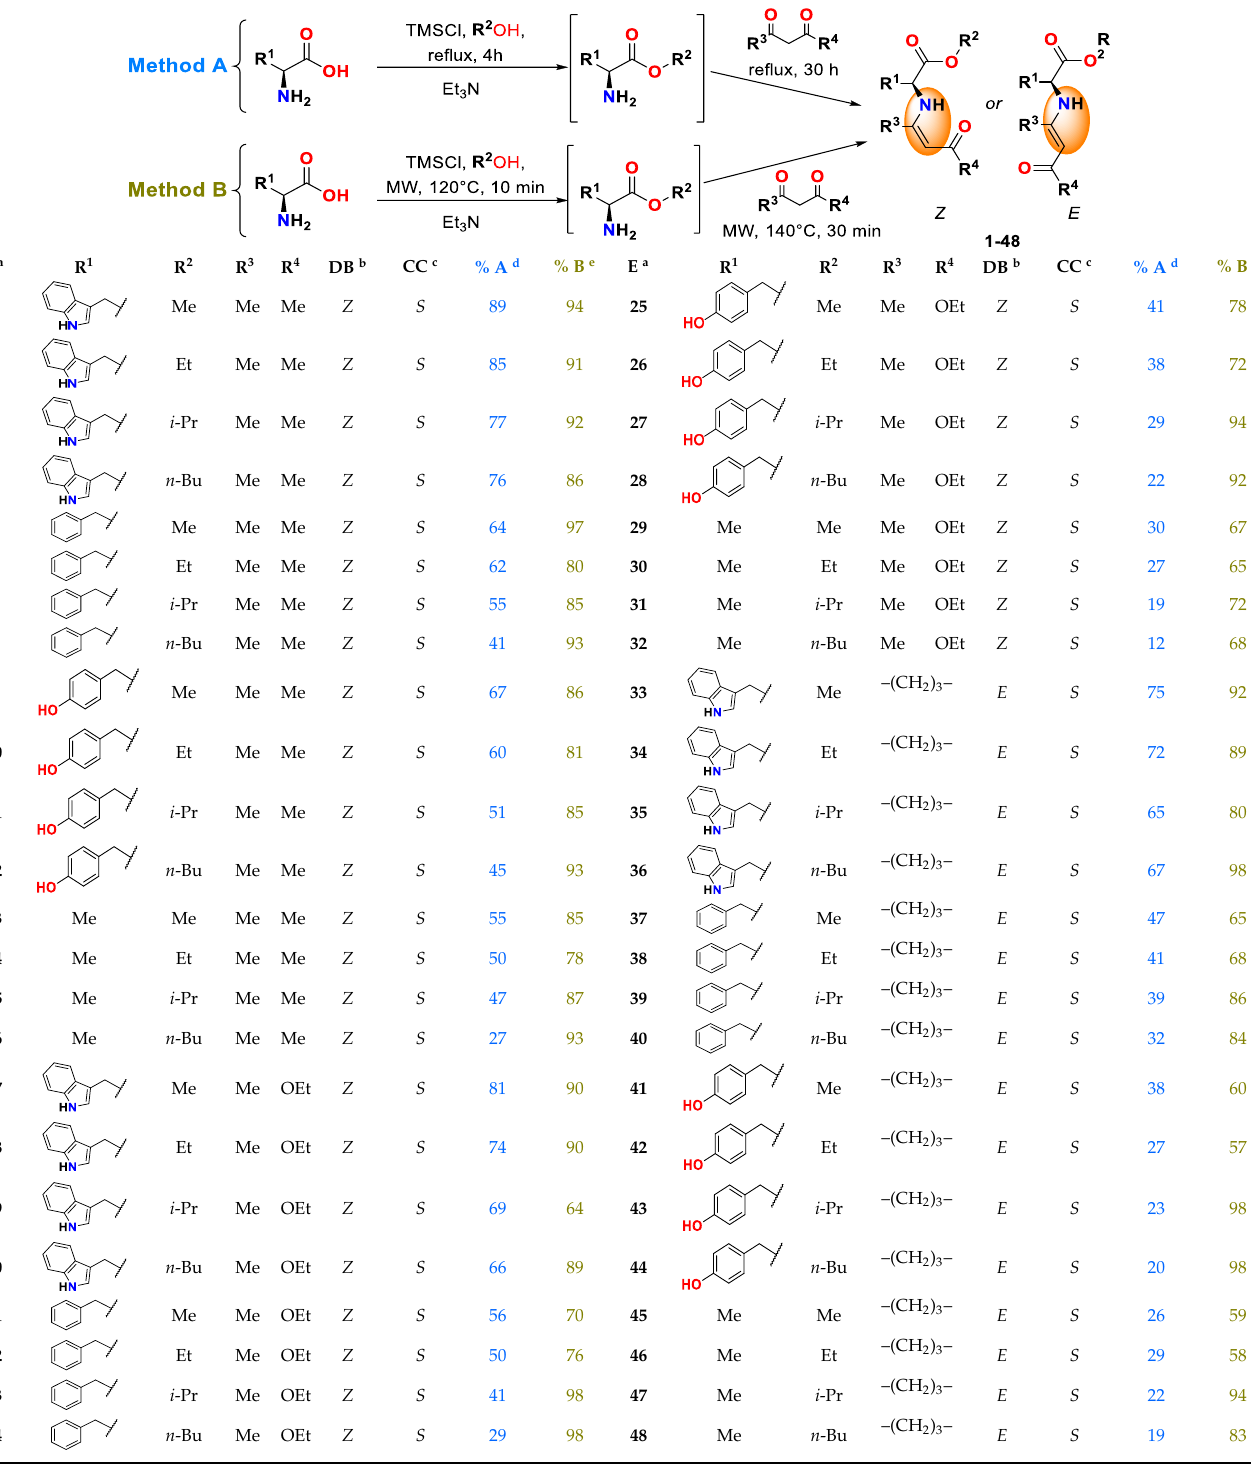
Table 1. Synthesis of the enamine-type Schiff bases 1–48 under methods A and B.